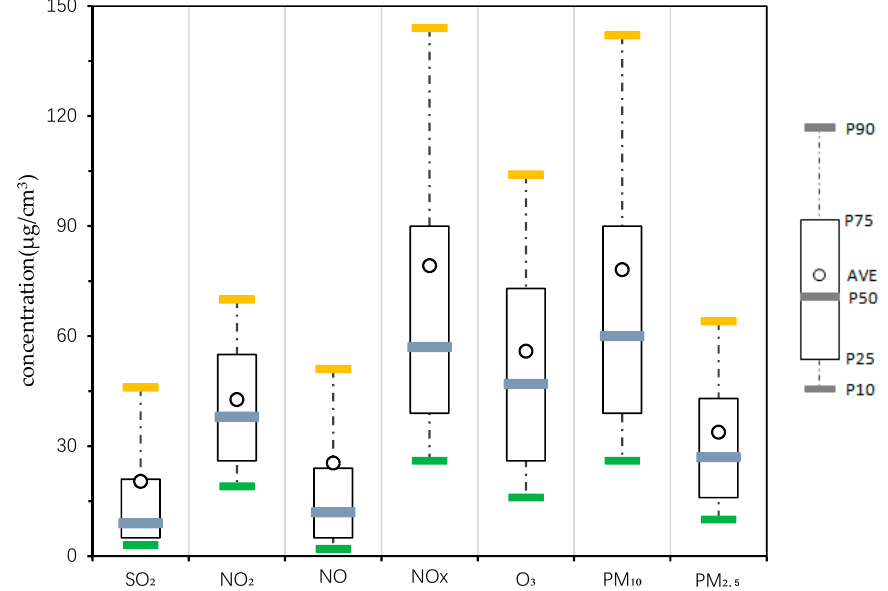
Figure 3. Hourly variation in the concentration of air pollutants in Changchun in 2018. (The circles represent the annual average concentration of air pollutants, and the horizontal lines represent the 90th, 75th, 50th, 25th, and 10th percentiles).